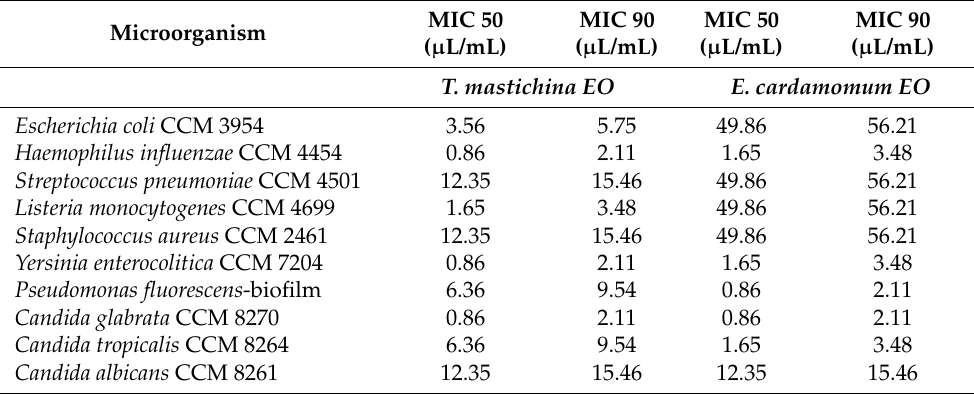
Table 6. Minimal inhibition